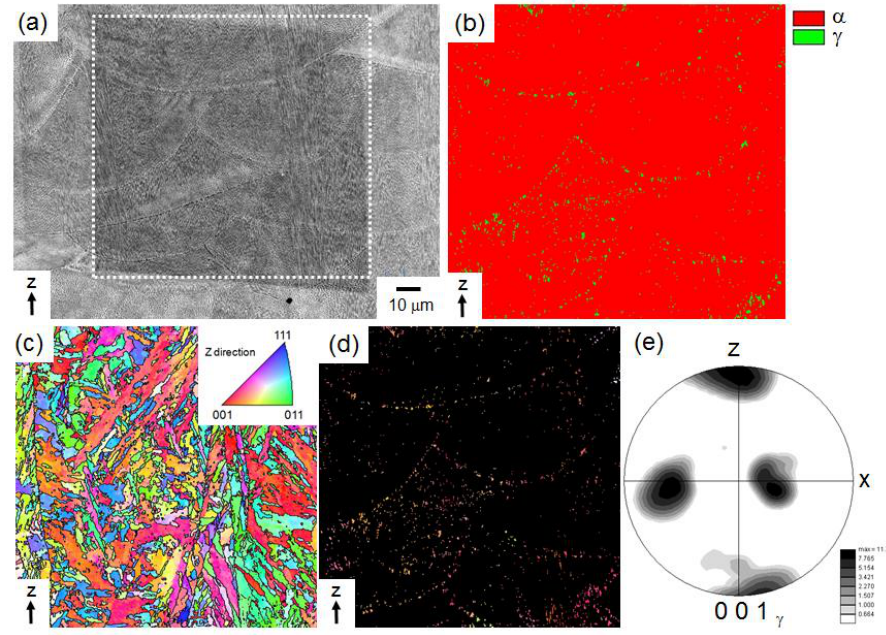
Figure 5. ( a ) SEM image depicting the microstructure of the SLM-fabricated maraging steel, ( b ) its corresponding phase map for α(bcc) and γ (fcc) phases, ( c ) orientation color map of the α phase, ( d ) corresponding phase map for α (bcc) and γ (fcc) phases; ( c ) orientation color map of the α phase; orientation color map of the γ phase, and ( e ) stereographic projection of the 001 poles in the γ phase ( d ) orientation color map of the γ phase; and ( e ) stereographic projection of the 001 poles in the γ phase presented in Fig. 5(d). presented in Figure